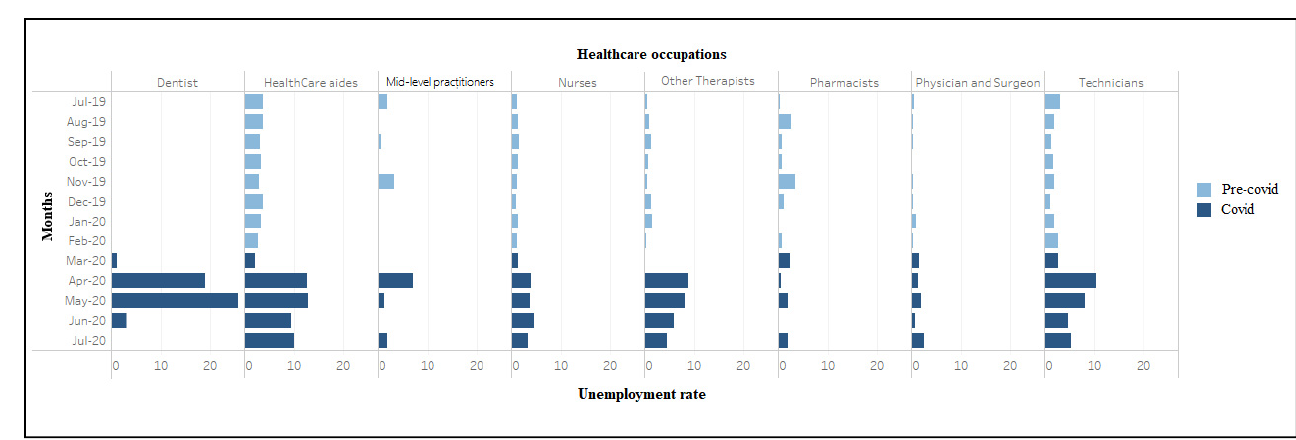
Figure 2. Unemployment rate (weighted) among workers in healthcare occupations (July 2019–2020). During March–April